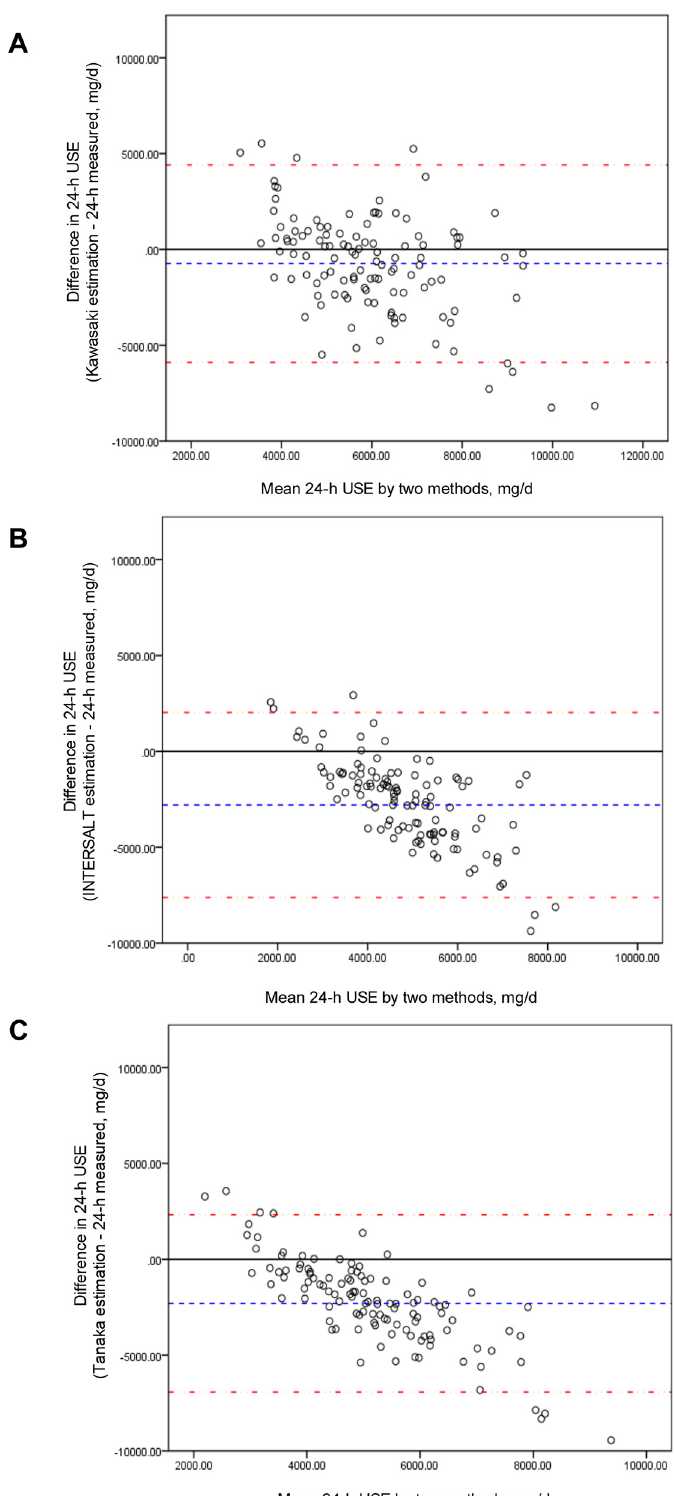
Fig 2. Bland-Altman plots of measured 24-h urine sodium excretion (USE) vs. Kawasaki (A), INTERSALT (B), and Tanaka (C) method estimated 24-h USE (mg/d). The difference between measured and estimated was all estimated values minus the measured values. The mid-dashed line was the